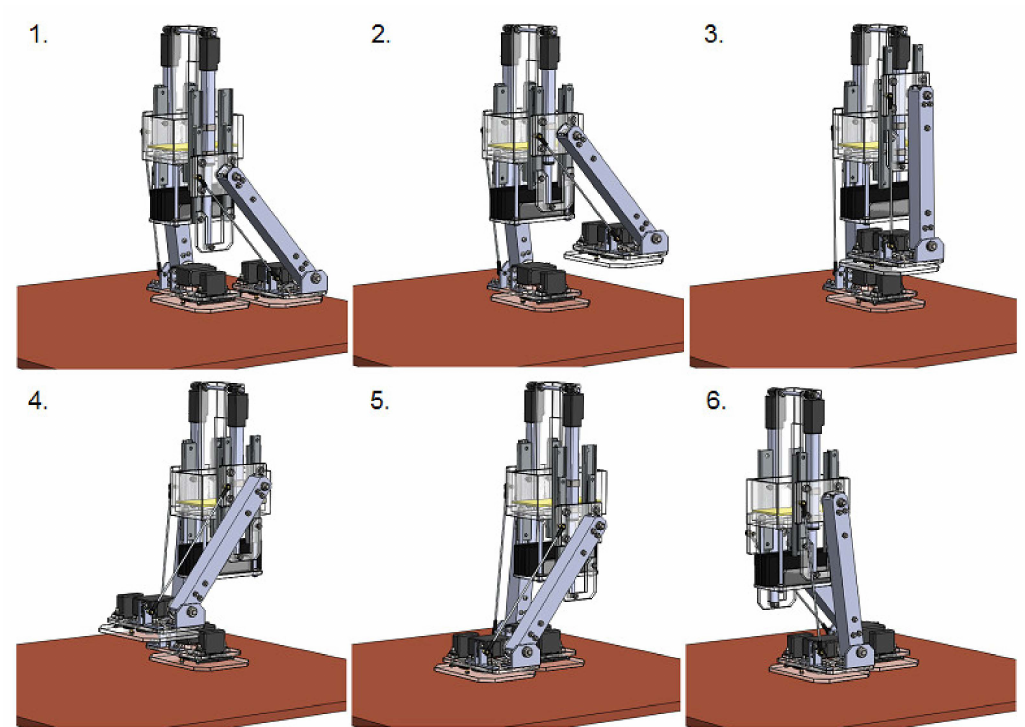
Figure 12. Snapshot sequence from the created robot step simulation. Legends: 1—the center of gravity of the robot is above the right foot; 2—the left linear actuator performs the upward stroke of